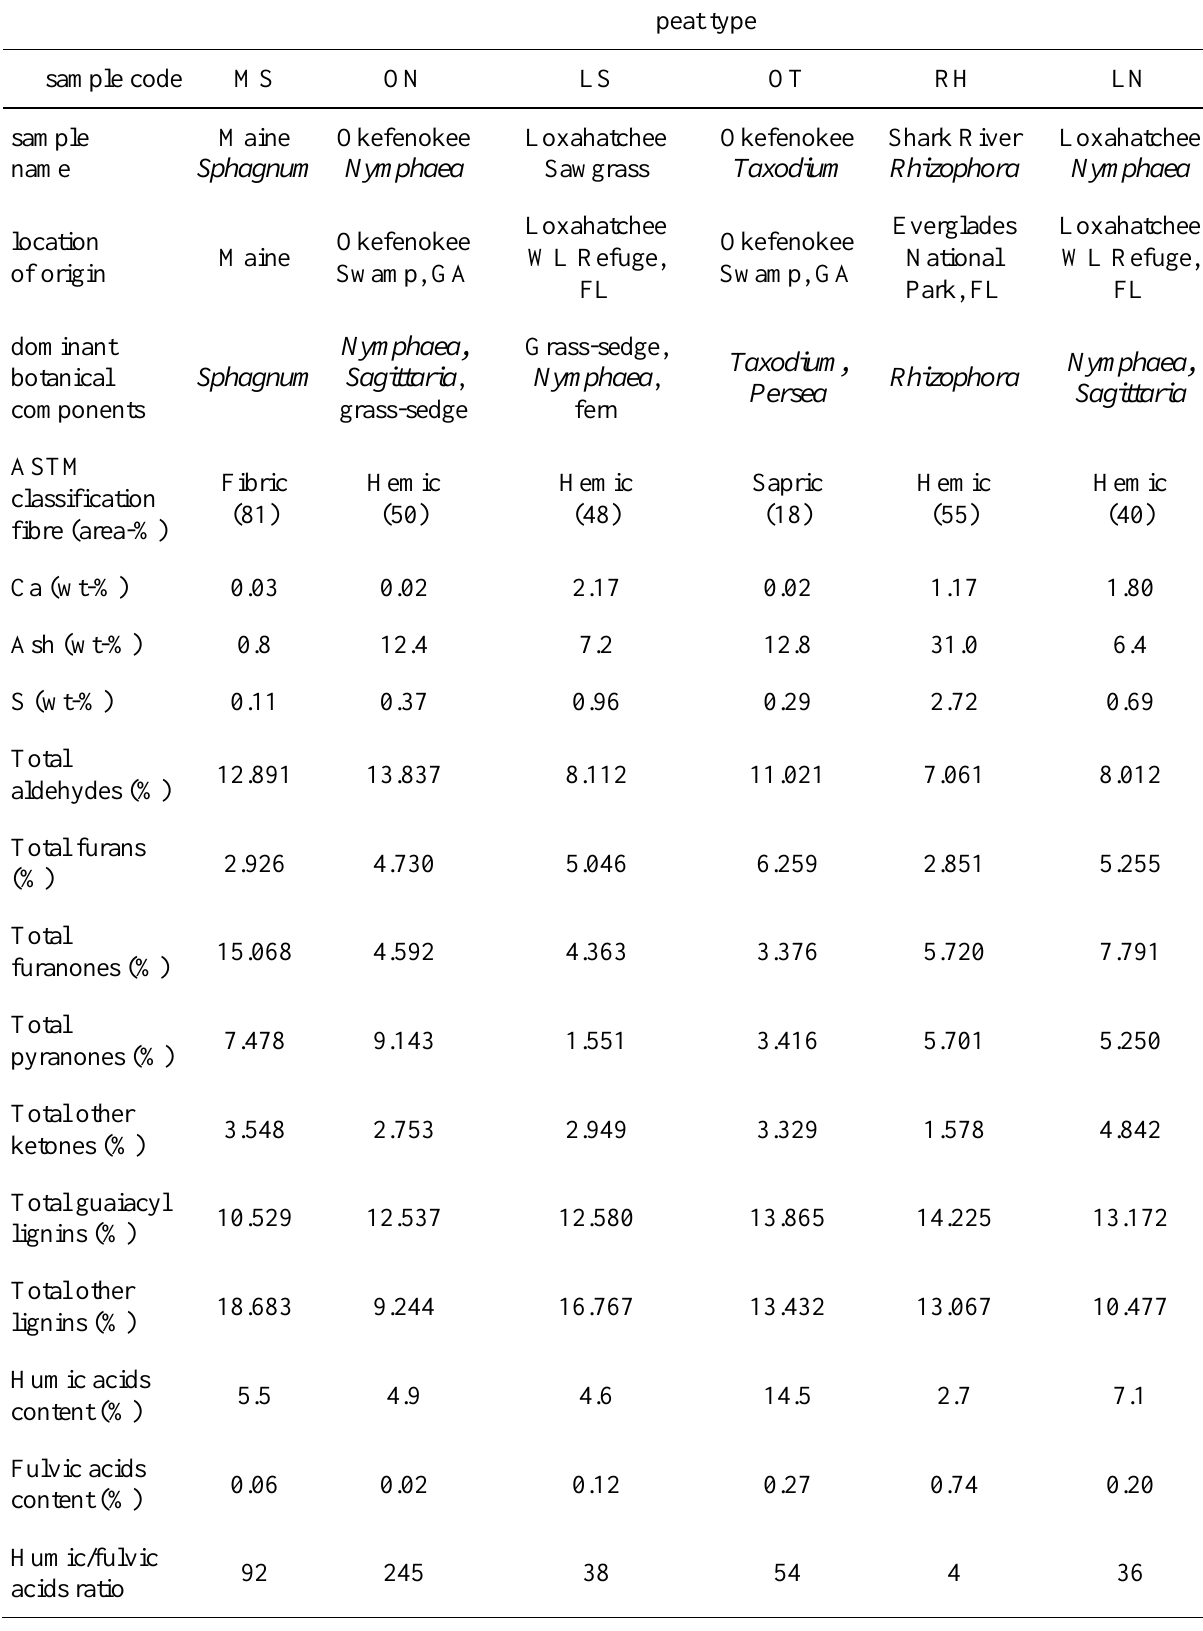
Table 1. Key characteristics of the peat samples used in this research (Cohen et al. 1991). ASTM: American Society for Testing and Materials (international standards organisation); FL: Florida; GA: